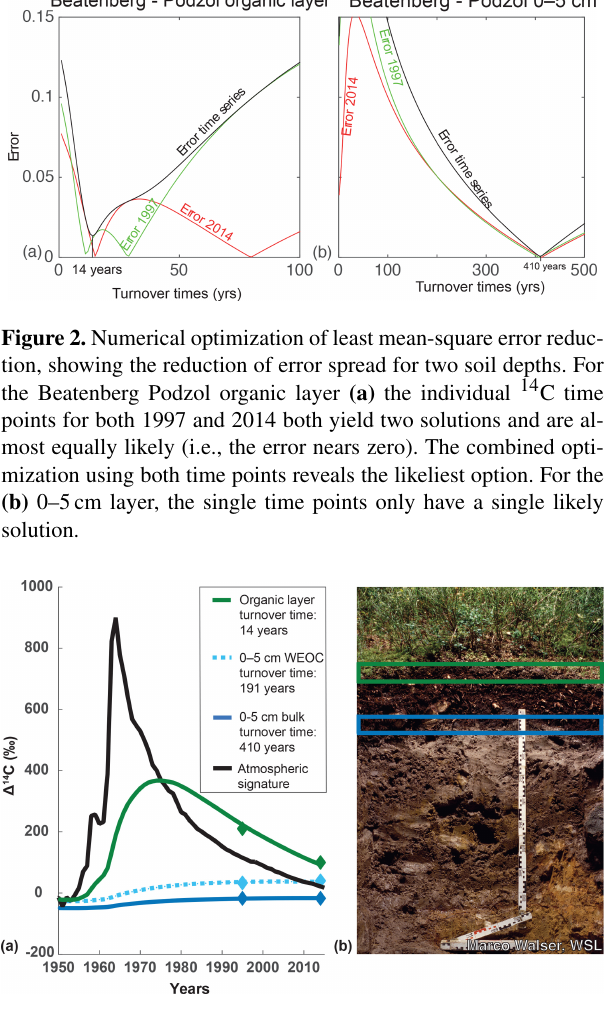
Figure 3. (a) Time series of soil carbon turnover time in years as determined by numerical modeling for (b) subalpine site Podzol Beatenberg. The bulk turnover time in the organic layer is rapid (14 years), followed by the turnover time of the water-extractable organic carbon (WEOC) (191 years) and the bulk turnover time of the soil (410 years) at 0–5cm depth. Photo soil profile courtesy of Marco Walser,